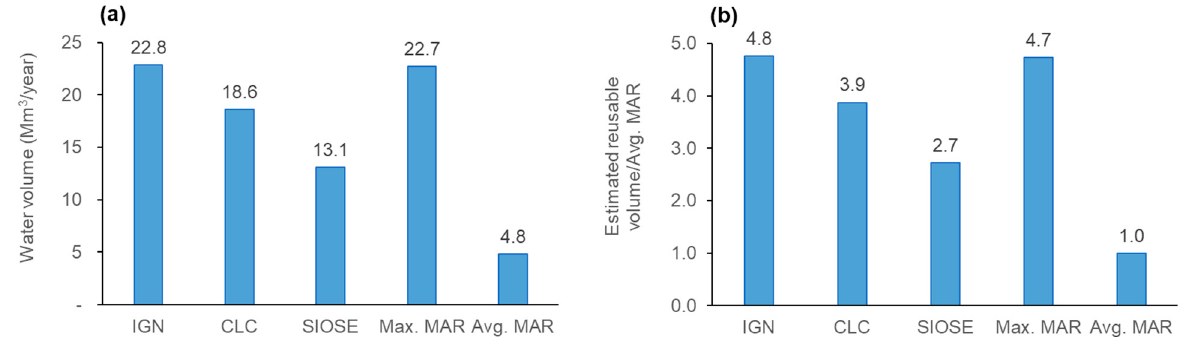
Figure 9. Potential recyclable wastewater: ( a ) in absolute values, and ( b ) as a percentage of the average managed aquifer recharge (MAR) volume between 2002 and 2020 (Avg. MAR). Max. MAR refers to the maximum annual allowed diversion of river water for MAR in El Carracillo and Santiuste together. Sources of urban area extension: IGN: National Geographic Institute; CLC: CORINE Land Cover; and SIOSE: Spanish Land Occupation Information System.